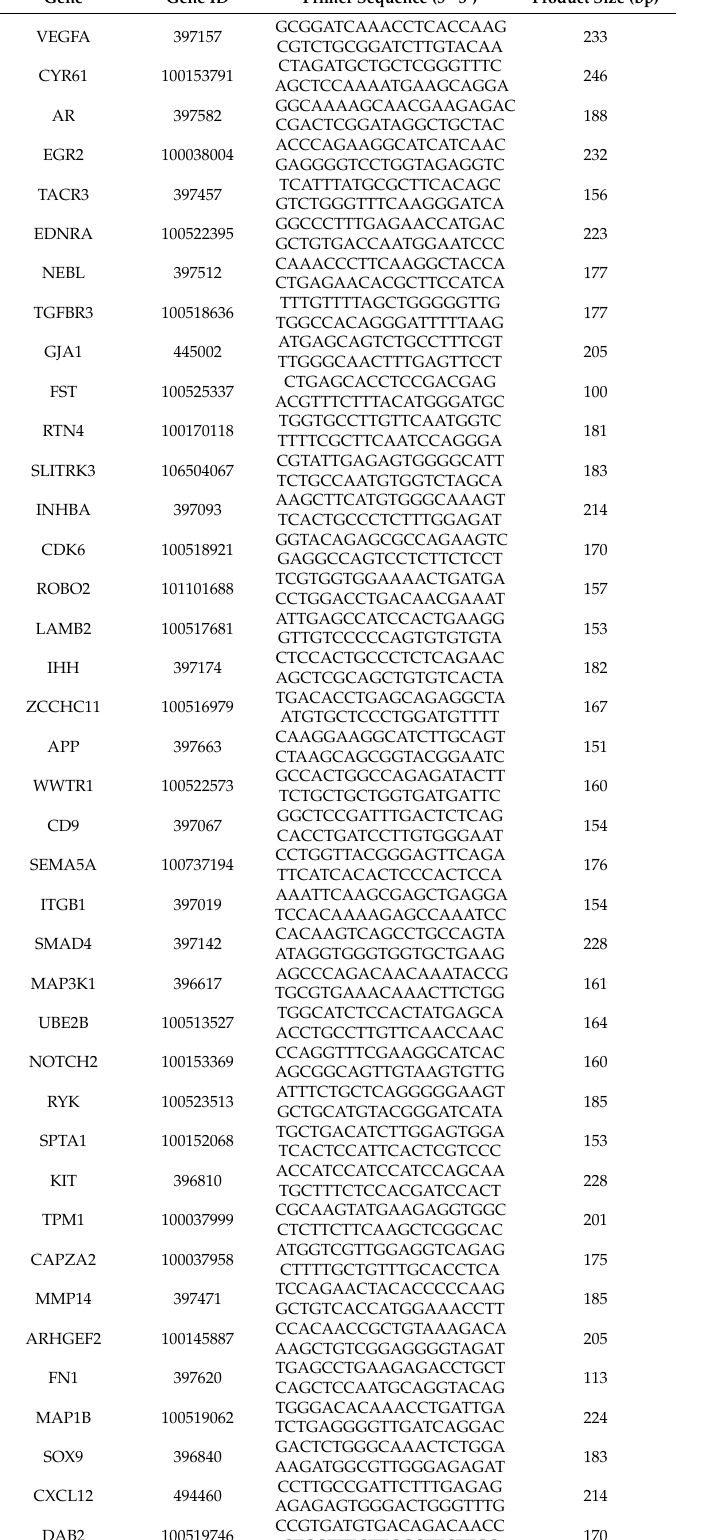
Table A1. Oligonucleotide